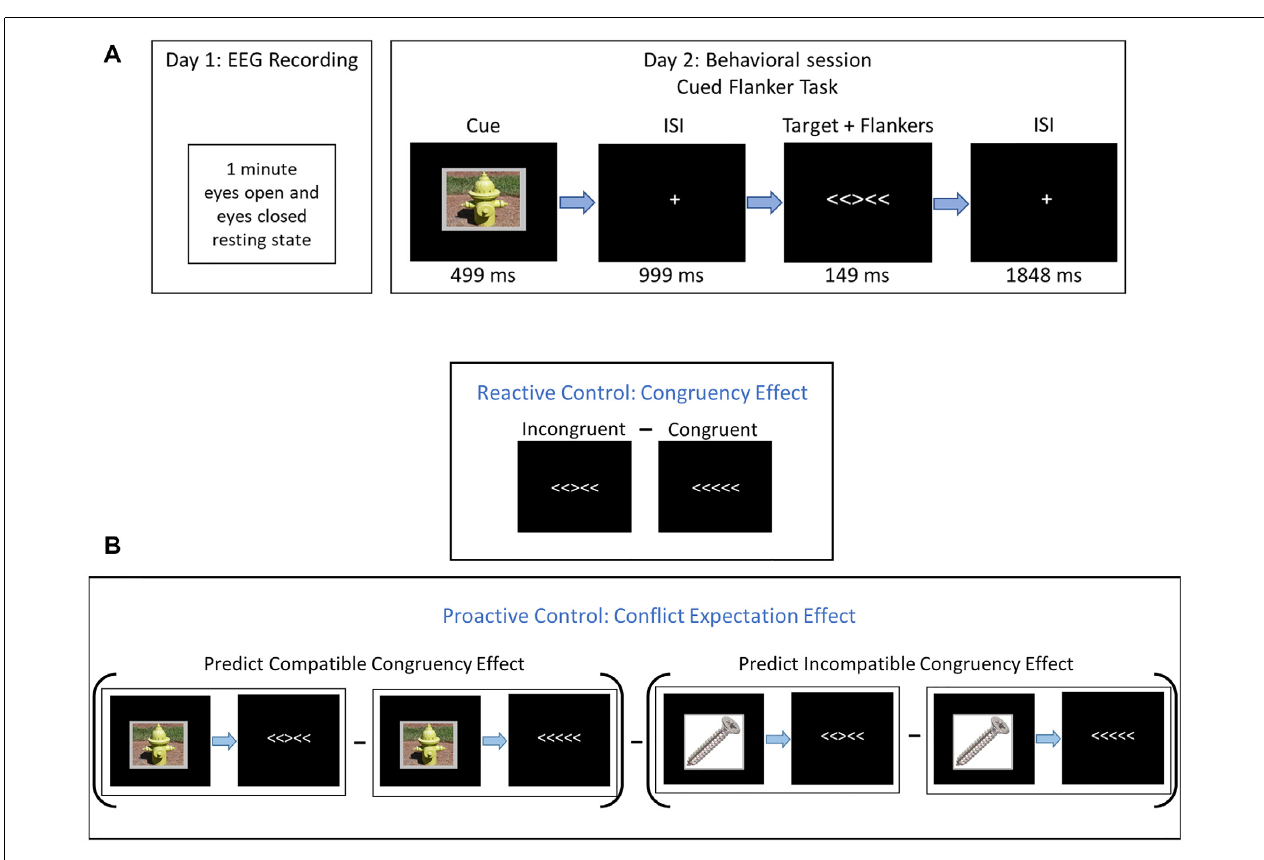
FIGURE 1 | Experimental procedures. (A) On Day 1, participants completed a 1-min resting-state electroencephalogram (EEG) recording with eyes closed and 1-min with eyes open. On Day 2, participants completed a cued flanker-task. Cues were neutral images from the IAPS (#7018 = screw, #7100 = fire hydrant, and #7705 = dresser). (B) Derivation of reactive and proactive control estimates. Reactive control was assessed with the congruency effect (CE), which is the difference in behavior between incongruent and congruent trials. Proactive control was assessed with the conflict expectation effect (CEE), which is the difference between